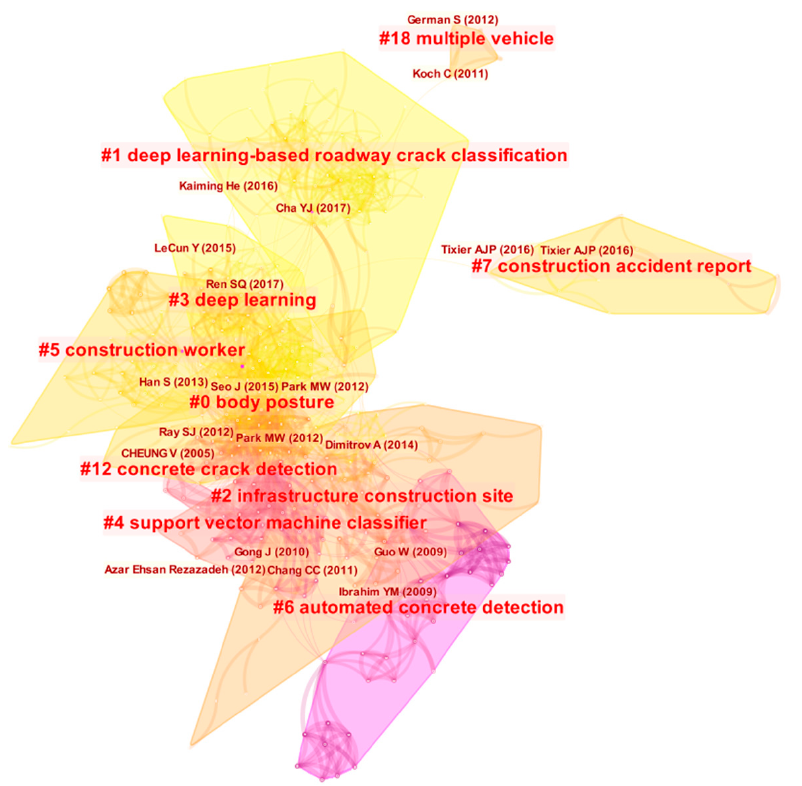
Appl. Sci. 2021 , 11 , 821 Figure 3. Cluster co-citation network. Figure 3. Cluster co-citation network. Table 2. Top-ranked clusters derived from three algorithms.